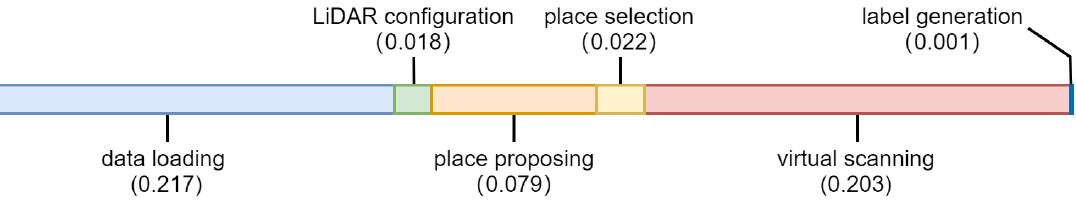
Figure 11. The time (in seconds) cost of each operation in the